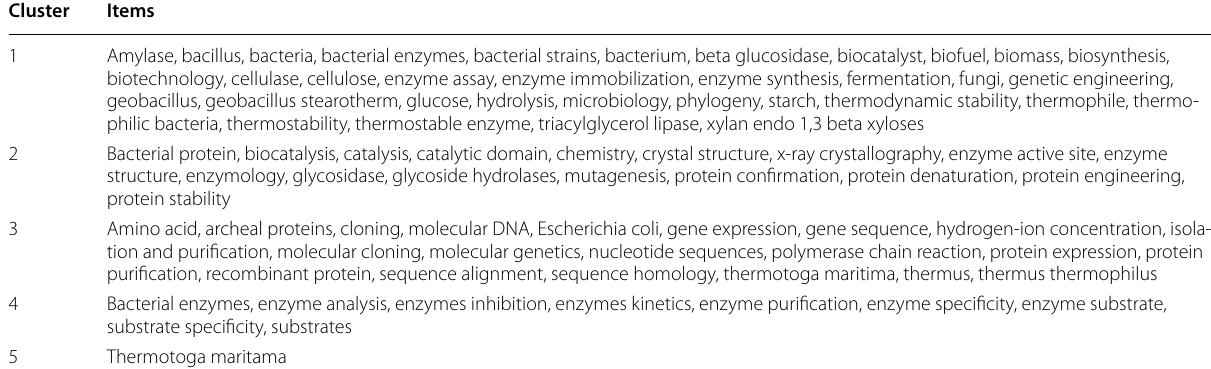
Table 3 Keyword clusters analysis of scientific publication of thermostable enzymes in the Scopus collection database (1976–2022) Cluster Items